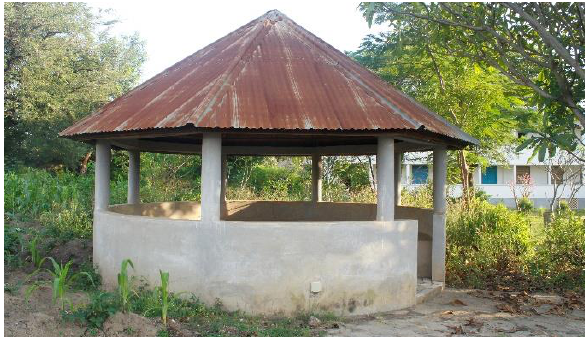
Figure 8. Renovated apatan . Formal consequences arising from the use of imported